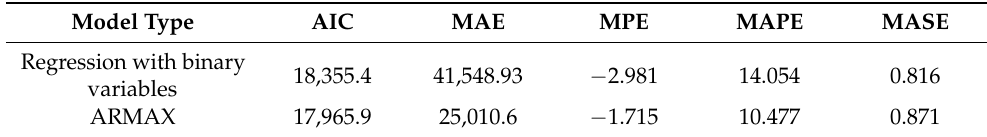
Table 6. Comparison of models.